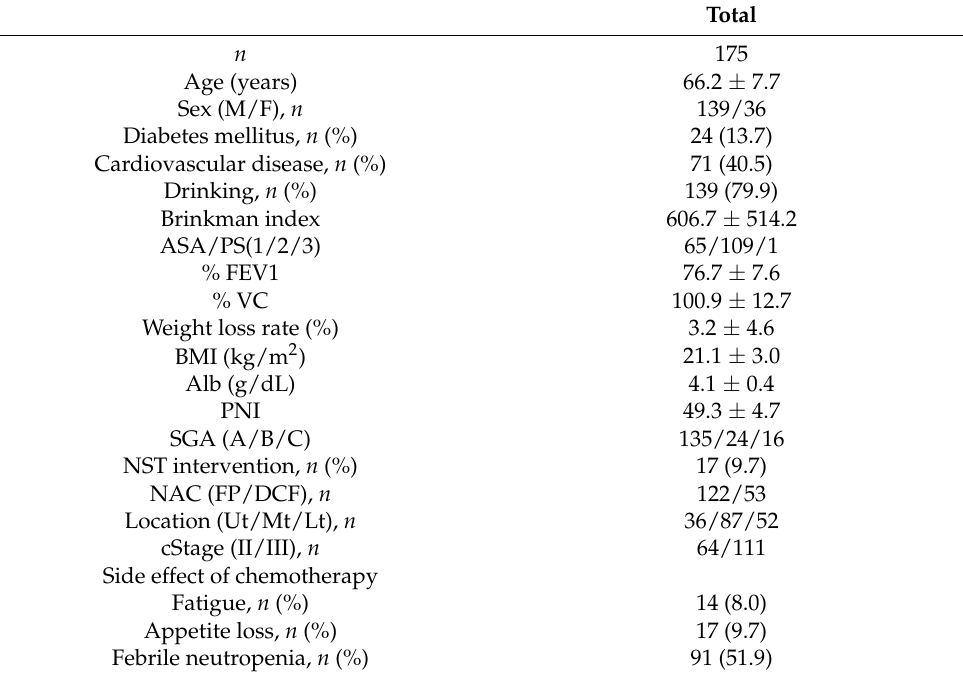
Table 1. Background factors of total patients.